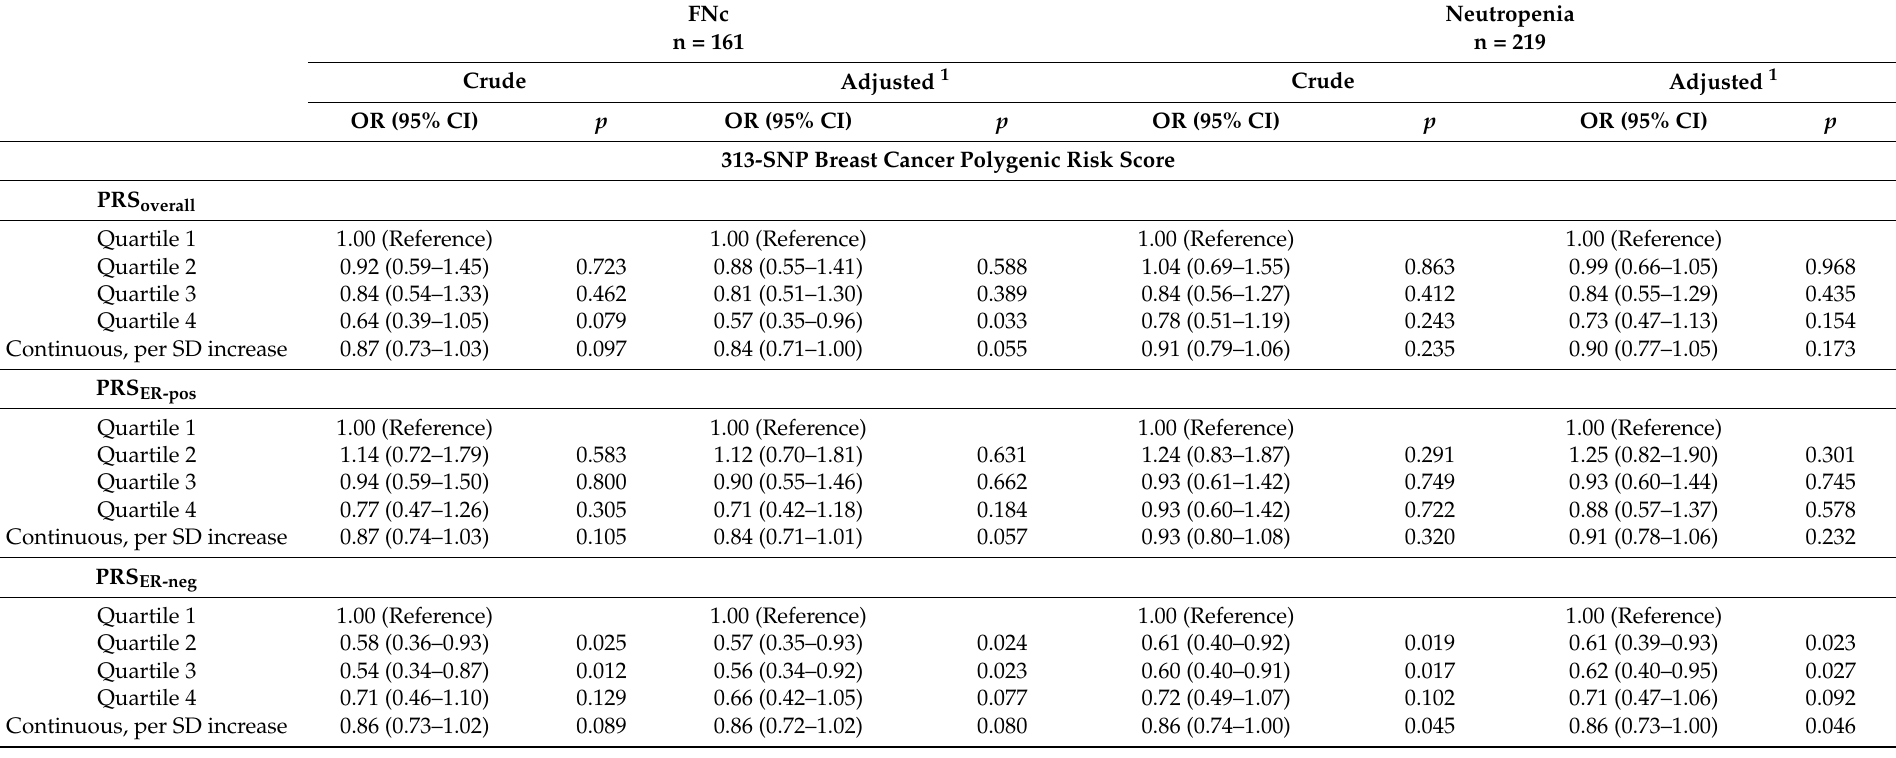
Table 2. Association between 313-single nucleotide polymorphism (SNP) breast cancer polygenic risk score and neutropenia-related outcomes in